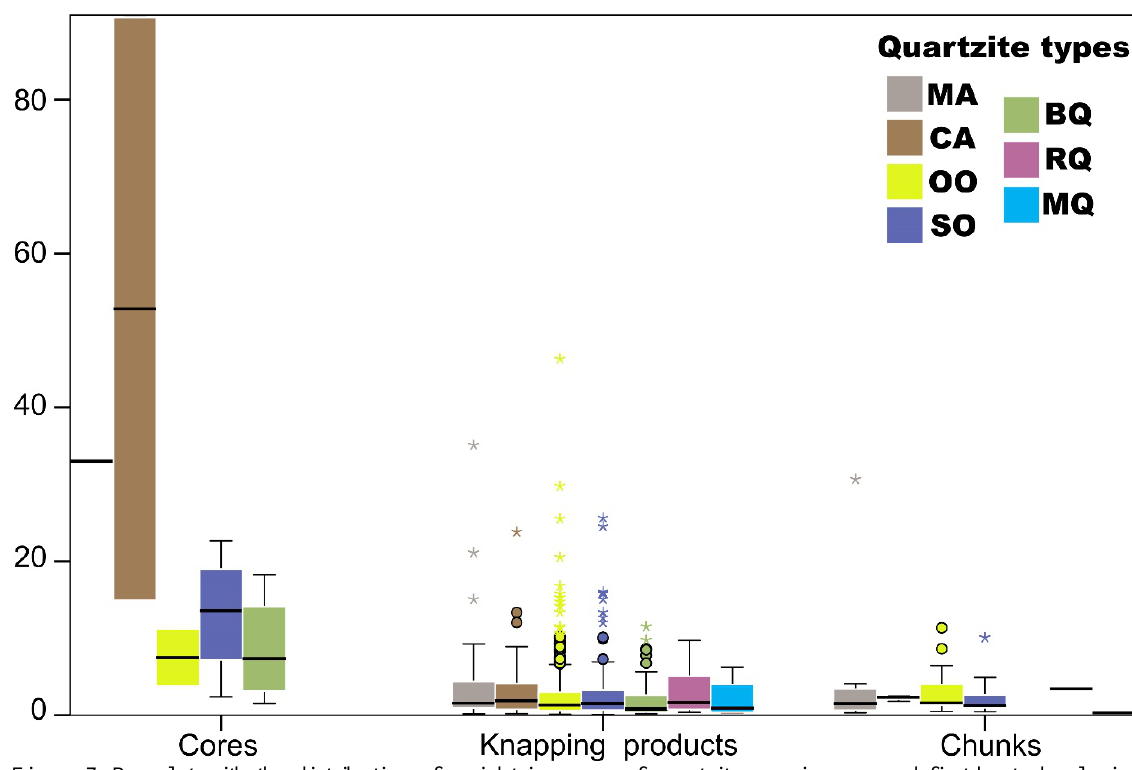
Figure 7. Boxplot with the distribution of weight in grams of quartzite remains grouped first by technological order and by raw material in the chart on the left, and by petrogenetic type in the chart on the